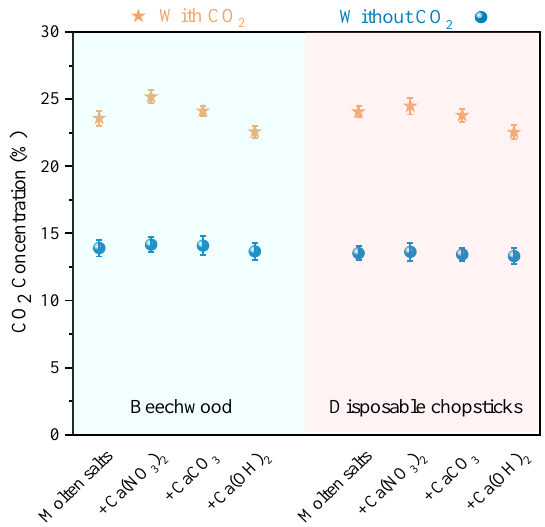
Figure 10. CO 2 concentration after combustion: with/without CO 2 before